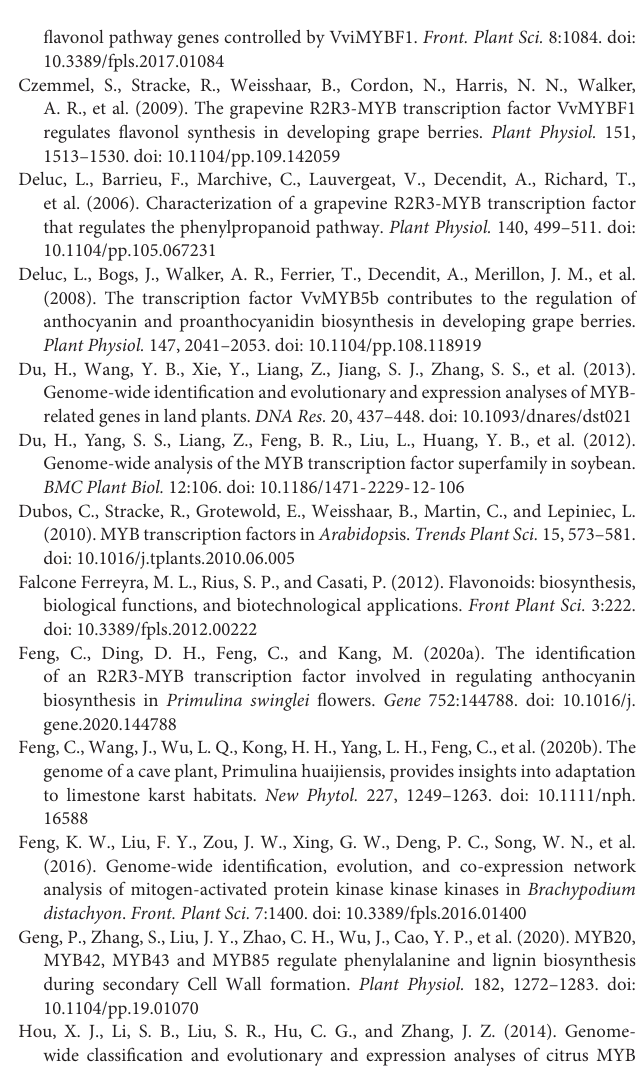
Supplementary Table 4 | Primers used for quantitative real-time PCR analysis. homologous genes in Arabidopsis; (3) without meeting the first and second principles, MrMYB genes were named according to the order of chromosome location. Supplementary Table 6 | The Ks value for tandemly and syntenically duplicated MrMYB genes. Supplementary Table 9 | Numbers of plant MYBs in the four different